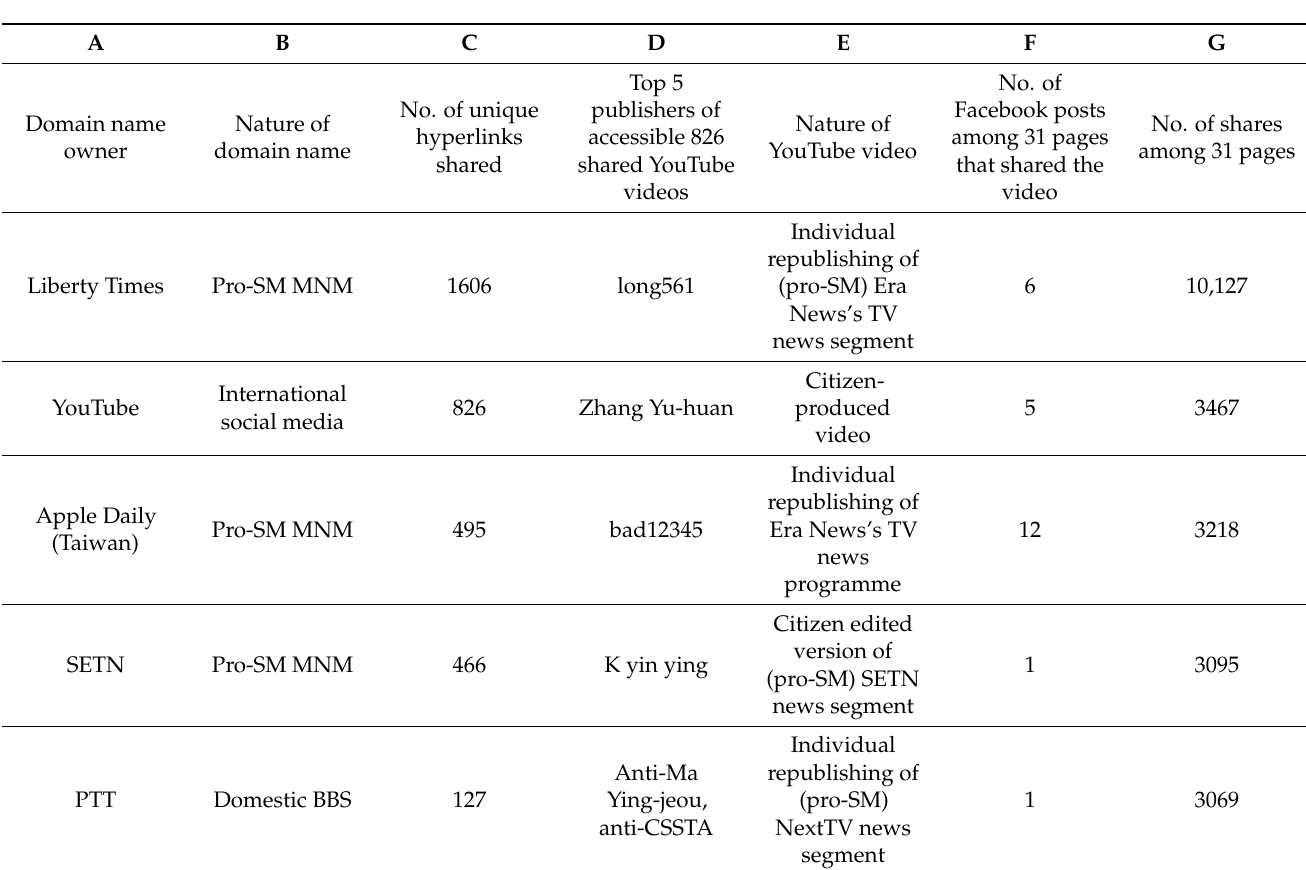
Table 4. Top five domains in external content shared on public Facebook pages/groups during